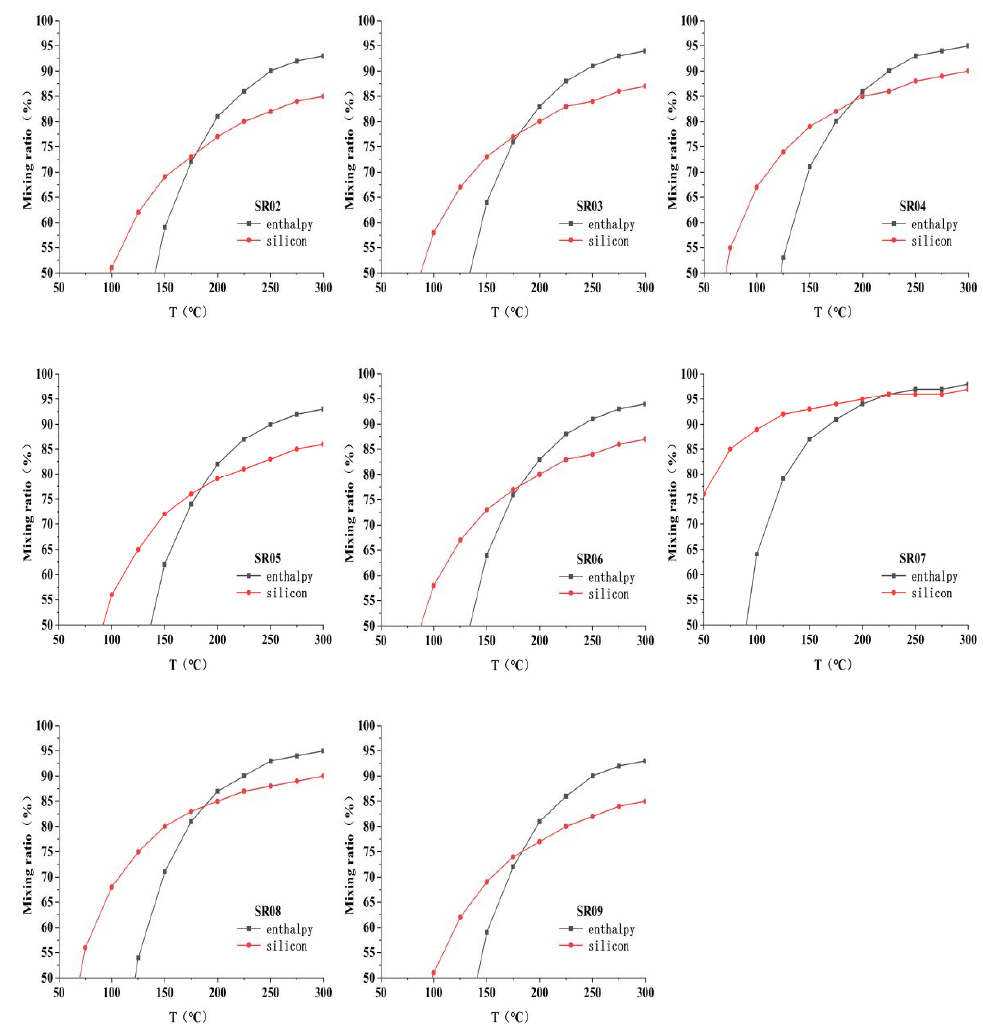
Figure 9. Relationship between the heat storage temperature and the mixing ratio. The intersection between the two curves represents the mixing ratio and the heat storage temperature. The black squares represent the enthalpy curve; the red circles represent the silicon concentration. Table 6. Geothermal water circulation depth in the Rongcheng Bulge area.